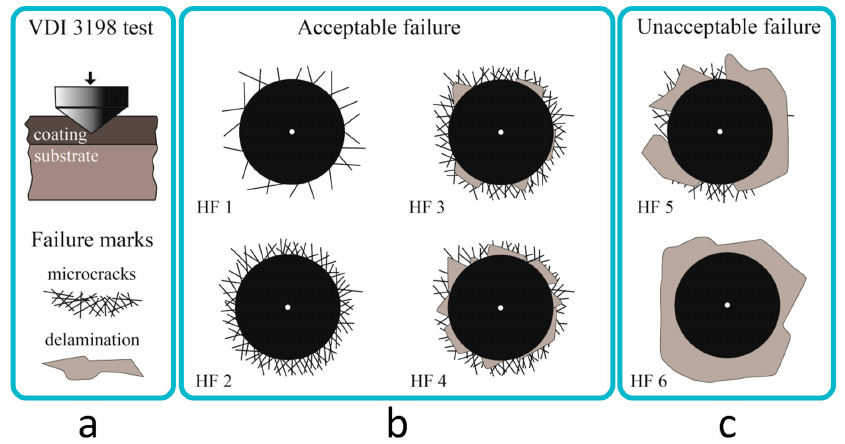
Figure 2. VDI 3198 indentation tests ( a ) and classification of the results as acceptable failure ( b ) and unacceptable failure of the film integrity ( c ).